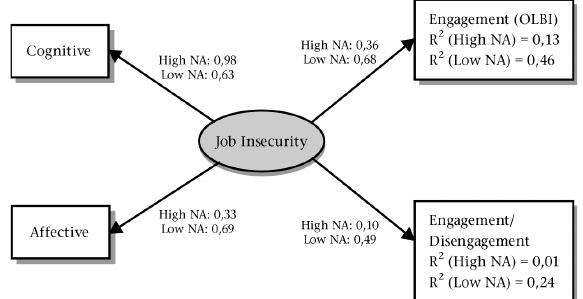
Figure 1: Structural model of job insecurity, burnout, and work engagement of low and high negative affectivity (NA) groups